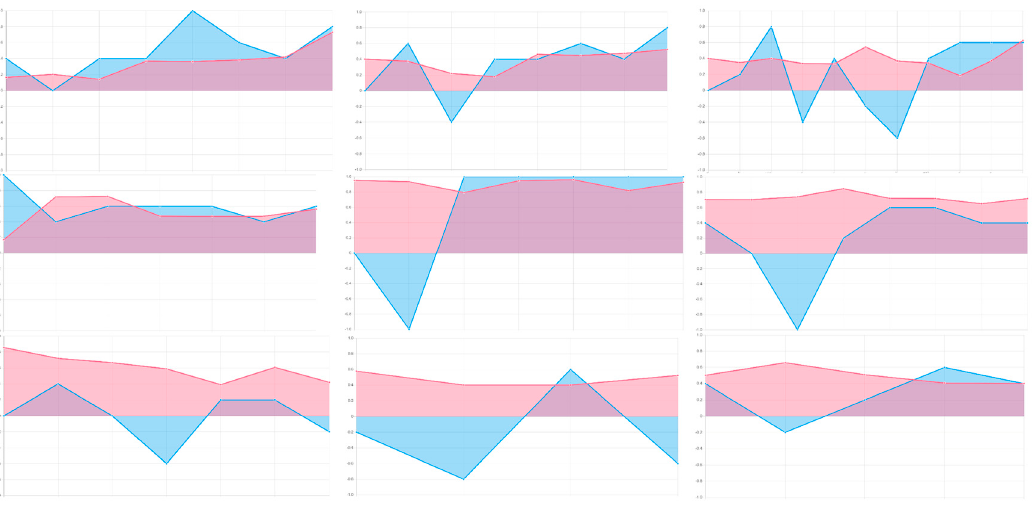
Figure 8. Predicted against actual rating for the visit for each of the 9 participants. The predicted score is denoted in red and the actual user rating in blue.